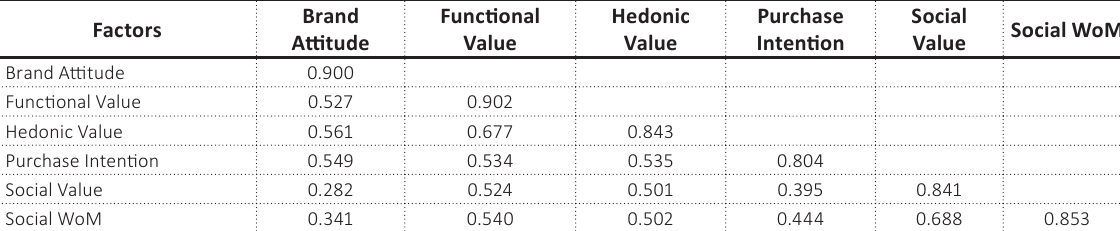
Table 4. Discriminant